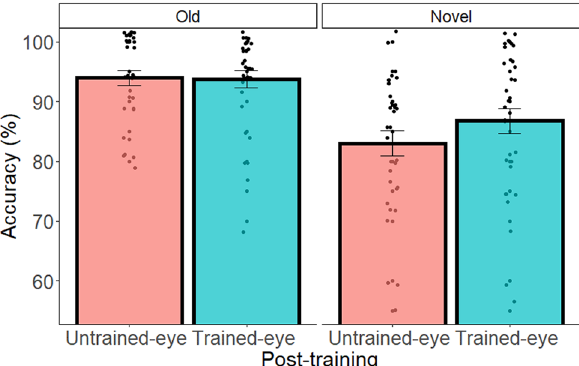
Figure 2. Accuracy for each individual (dot) as a function of Eye (trained-eye condition vs. untrained-eye condition) and Problem Novelty (old figures from the training task vs. novel figures) in the figural-spatial task. Error bars represent standard error of the mean (SEM). In order to compare the influence of the figural-spatial training on the trained vs. untrained eye, in the pre-training stage no figural-spatial task was presented, as in the other tasks. This was done in order to manipulate the specific influence of the figural-spatial training only on the trained